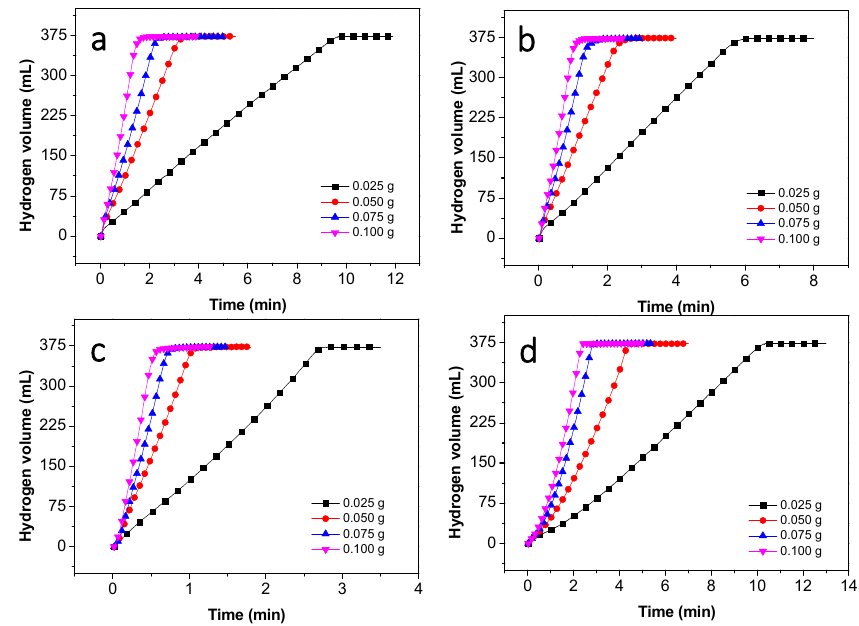
Figure 8. Effect of catalyst dosage on the HG rate for Co–B catalysts prepared in ( a ) water; ( b ) methanol; ( c ) acetone; and ( d ) acetonitrile. (Batch system; 298 K; 1.5 wt % NaBH 4 .)